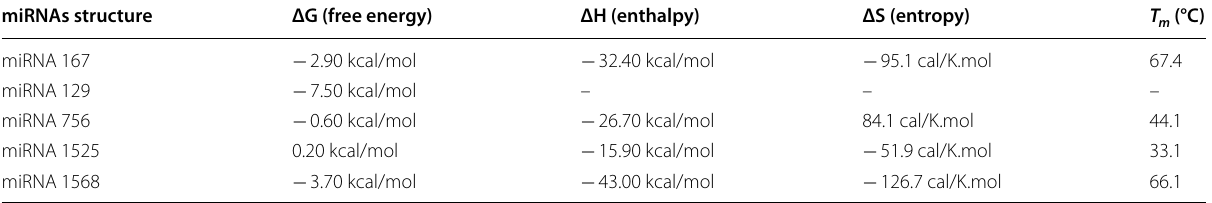
Standard errors are roughly